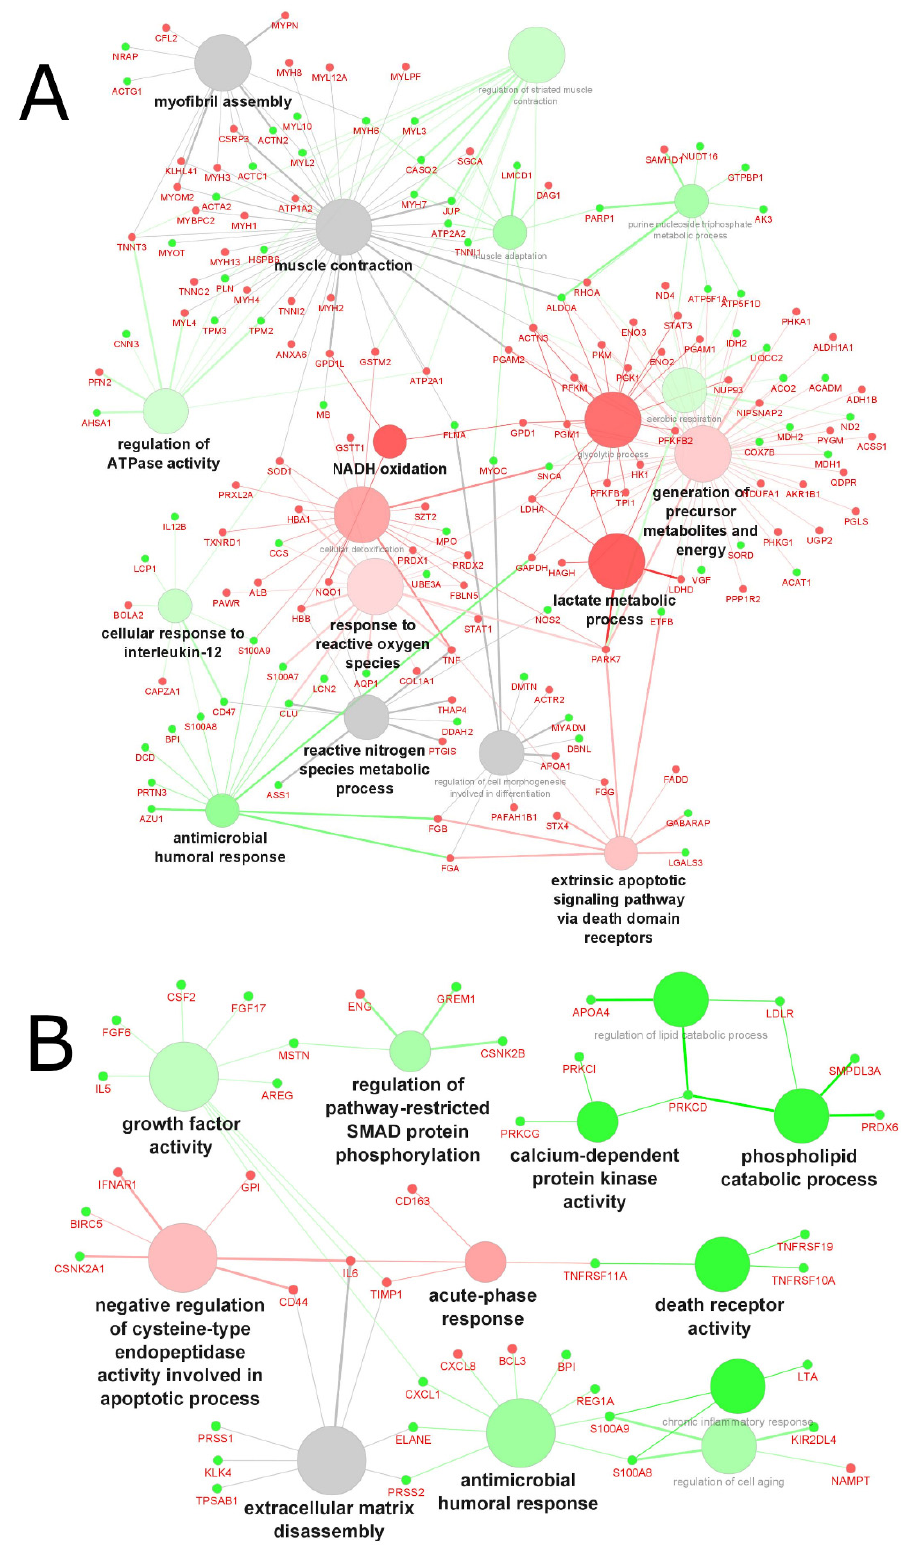
Figure 3. GO analysis of biological processes in cachexia-related muscle atrophy, based on grouped molecules identified in ( A ) tissue samples and ( B ) biofluid samples from 24 proteomics studies. Red nodes represent upregulated processes, green nodes represent downregulated processes, grey nodes represent common (shared) up- and downregulated processes; font and node sizes reflect statistical significance (kappa score = 0.4 and p -value < 0.01).